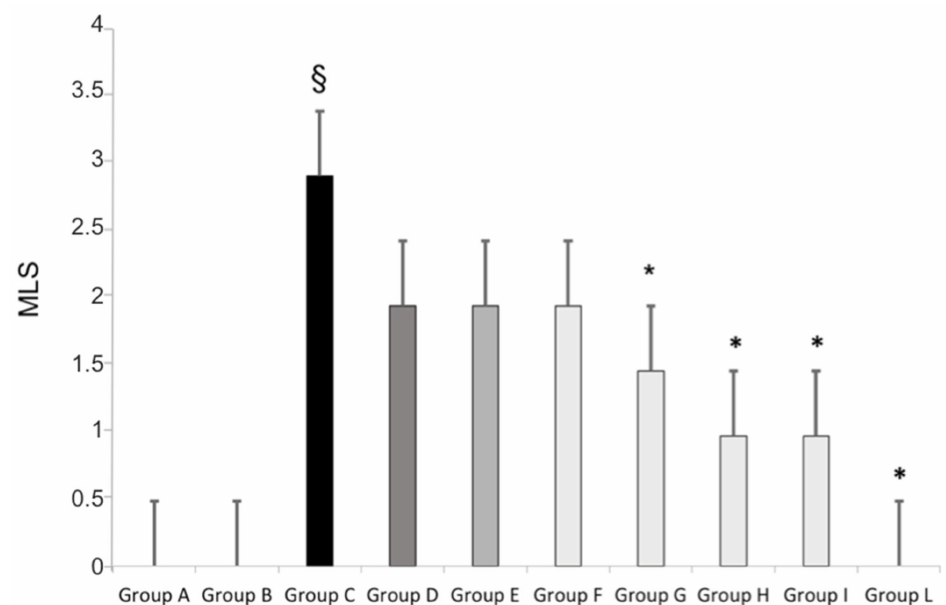
Figure 1. Gastric modified Lanza score (MLS) gastroscopy evaluation in healthy volunteers receiving placebo orally or sublingually (Groups A and B, respectively); receiving 100 or 50 mg of standard aspirin orally (Groups C and D, respectively); receiving 100 or 50 mg of standard aspirin sublingually (Groups E and F, respectively); receiving aspirin micronized and cogrinded with collagen orally (Groups G and H) or sublingually (Groups I and L). § p < 0.05 standard aspirin vs. placebo; * p < 0.05 collagen cogrinded aspirin vs. standard